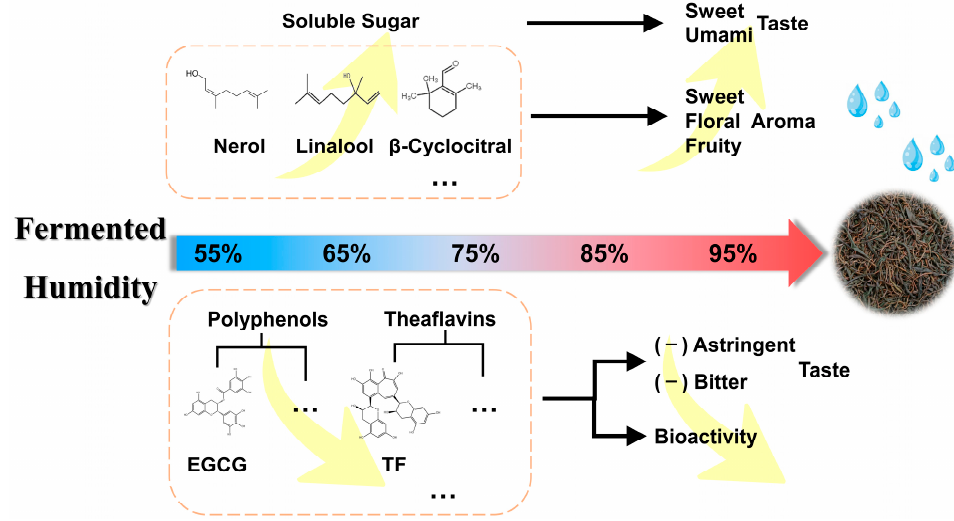
Figure 7. Schematic diagram for the main effects of fermentation humidity on congou black tea quality.